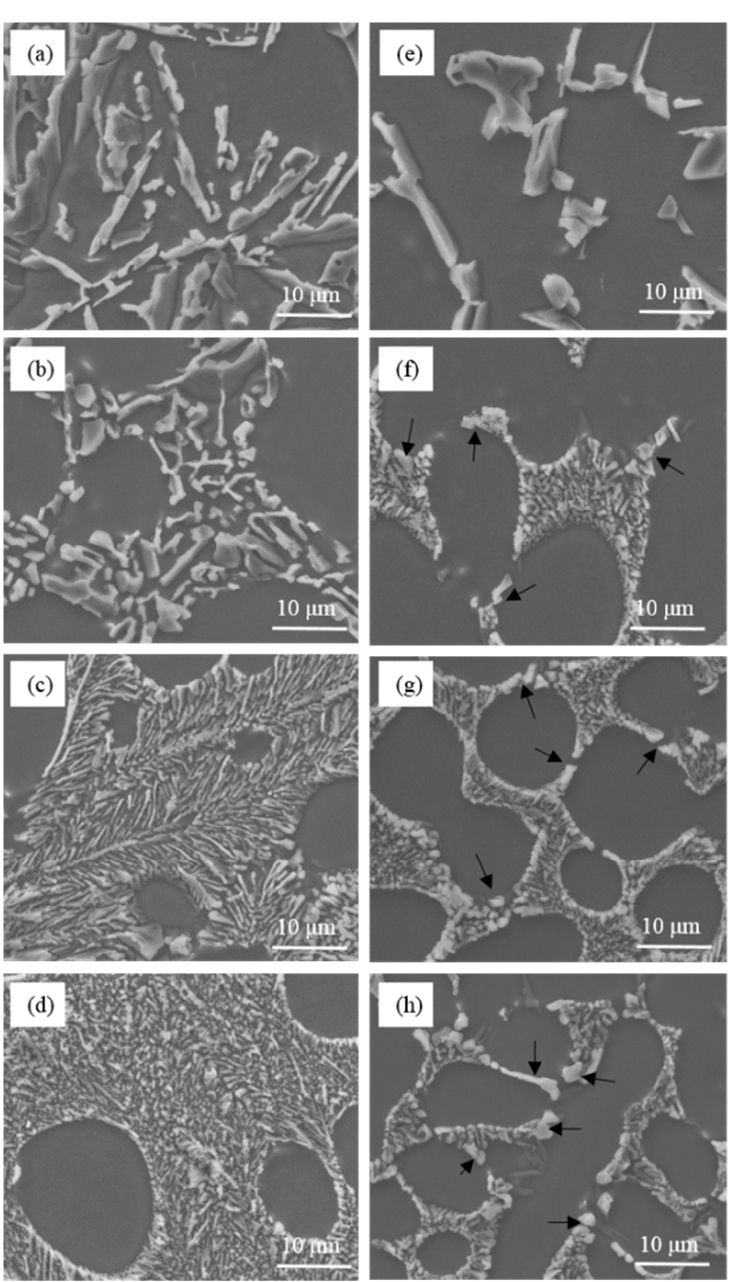
Figure 2. Microstructure of commercial pure Al-7Si alloy and Al-7Si-0.4Mg alloy with different Na-based modifier addition. ( a – d ) Al-7Si alloy; ( e – h ) Al-7Si-0.4Mg alloy; ( a , e ) without modifier; ( b , f ) with 0.2 wt.% modifier; ( c , g ) with 0.4 wt.% modifier; ( d , h ) with 0.6 wt.% modifier.